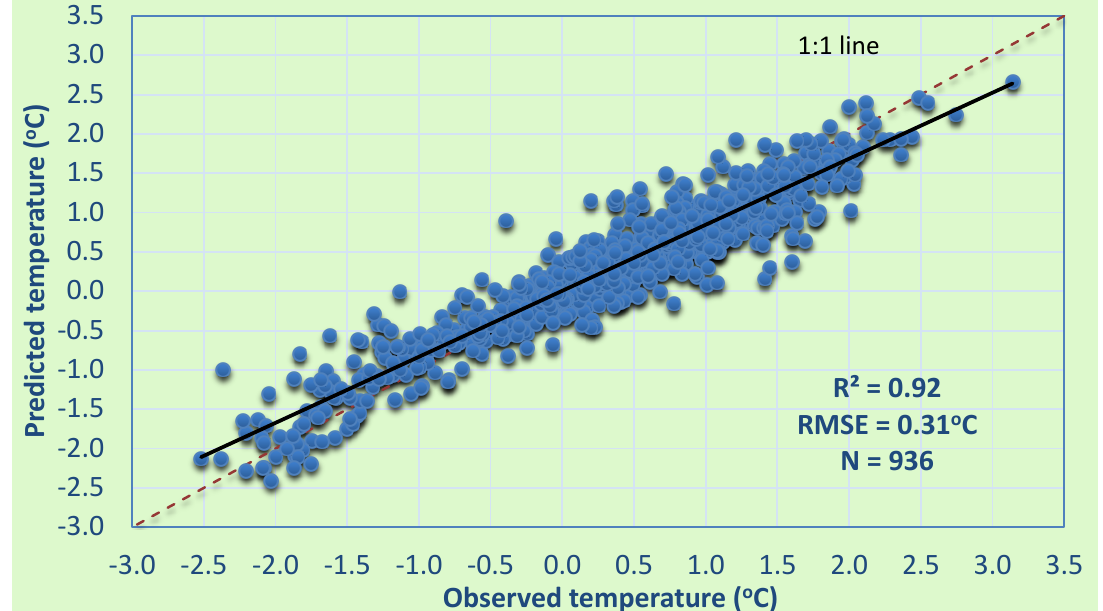
Figure 3. Model-predicted temperature anomalies vs. observed temperature anomalies. “N” is the number of points. RMSE: root mean square